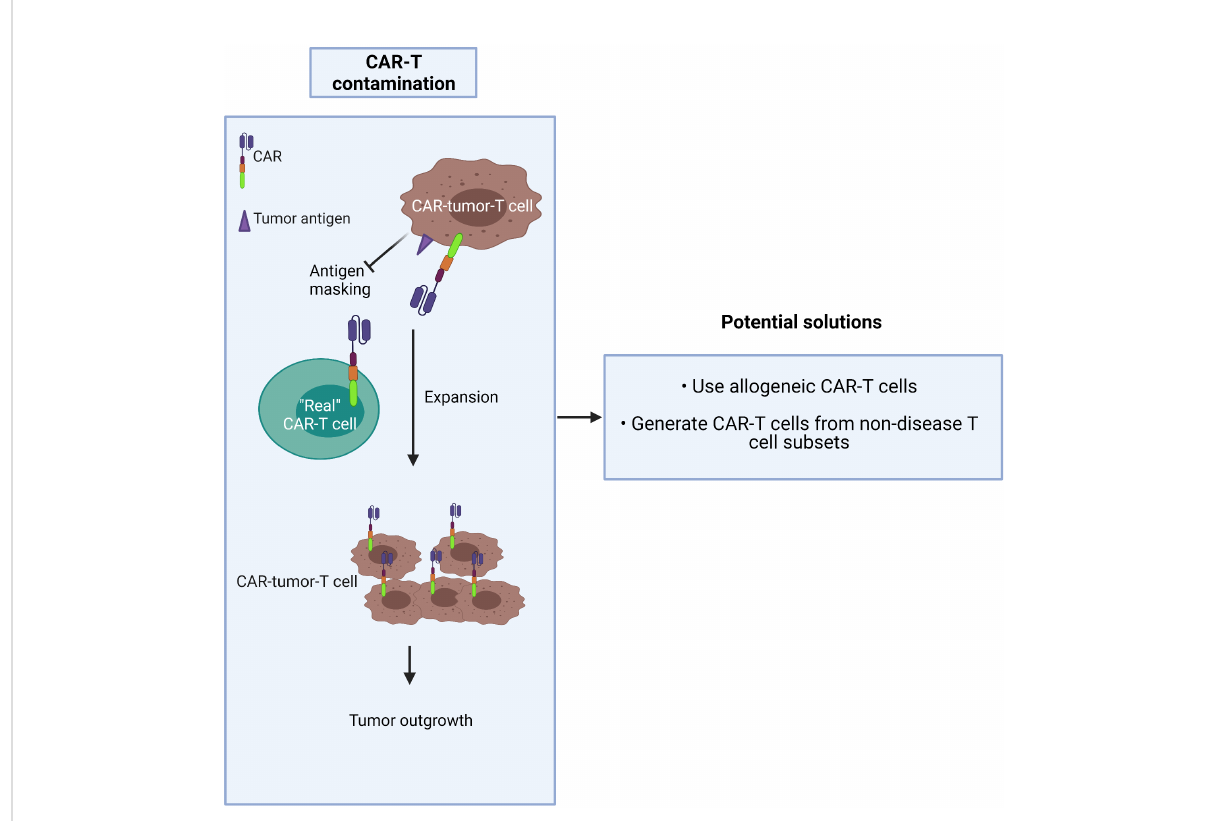
FIGURE 3 Malignant T cells may contaminate CAR-T cell